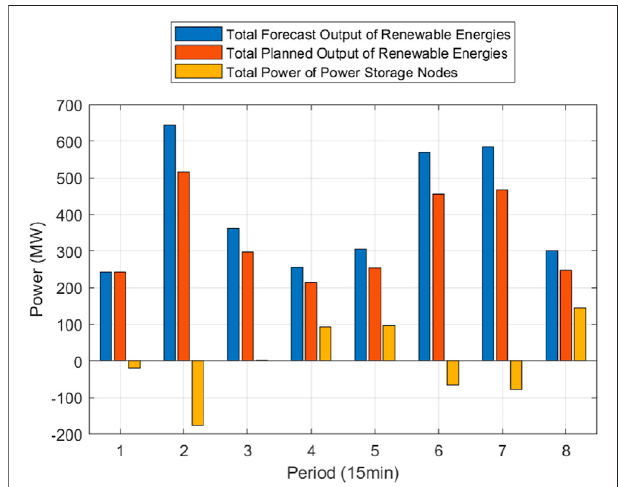
FIGURE 7 | Power supply bene fi ts in each period of the two systems.